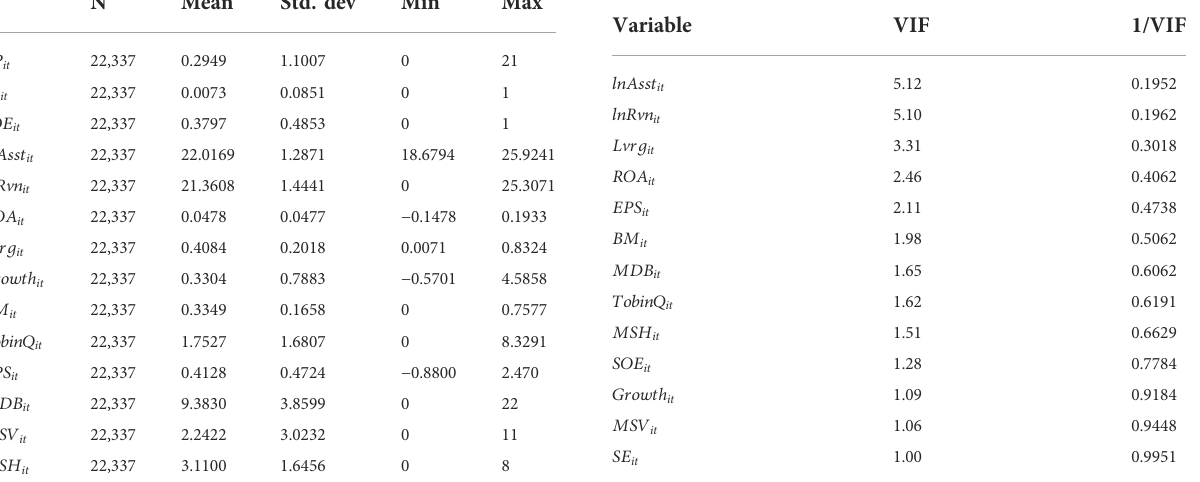
TABLE 3 Variance in fl ation factors of independent and control